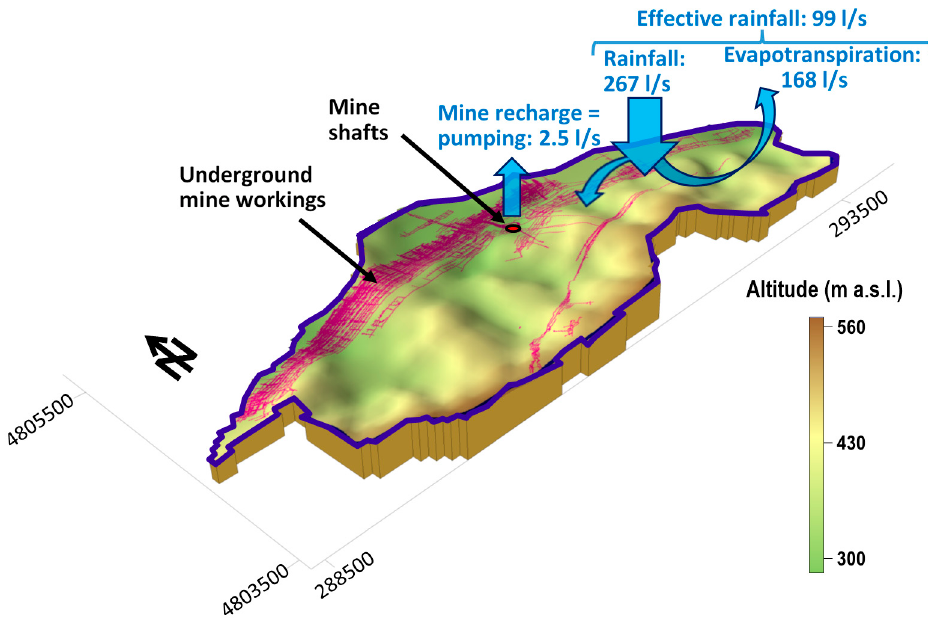
Figure 4. Recharge basin of the mine and conceptual hydrogeological model.